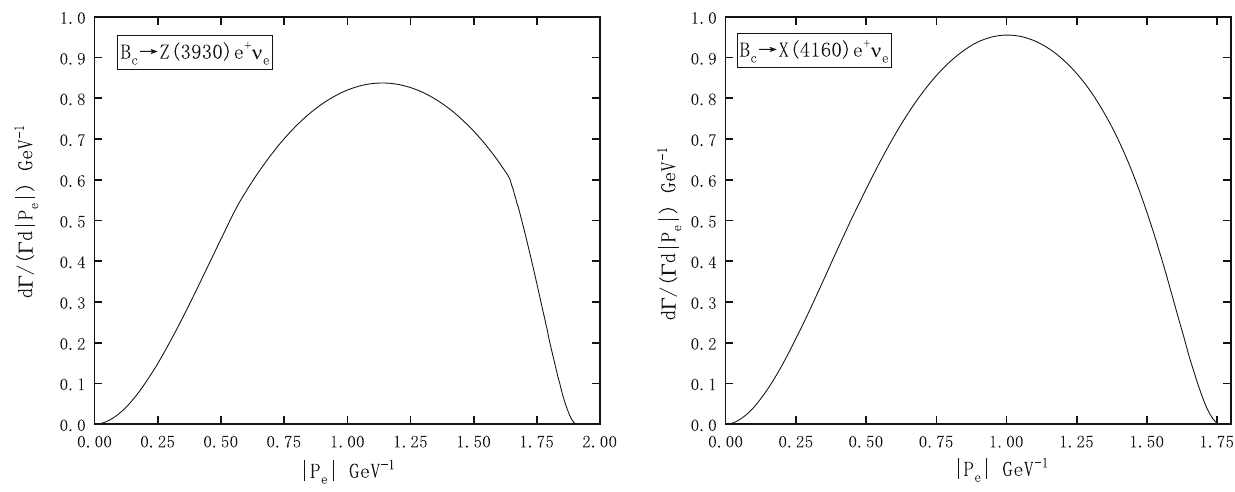
Fig. 5 The leptonic energy spectra of semileptonic decay B c to Z ( 3930 ) and X ( 4160 )